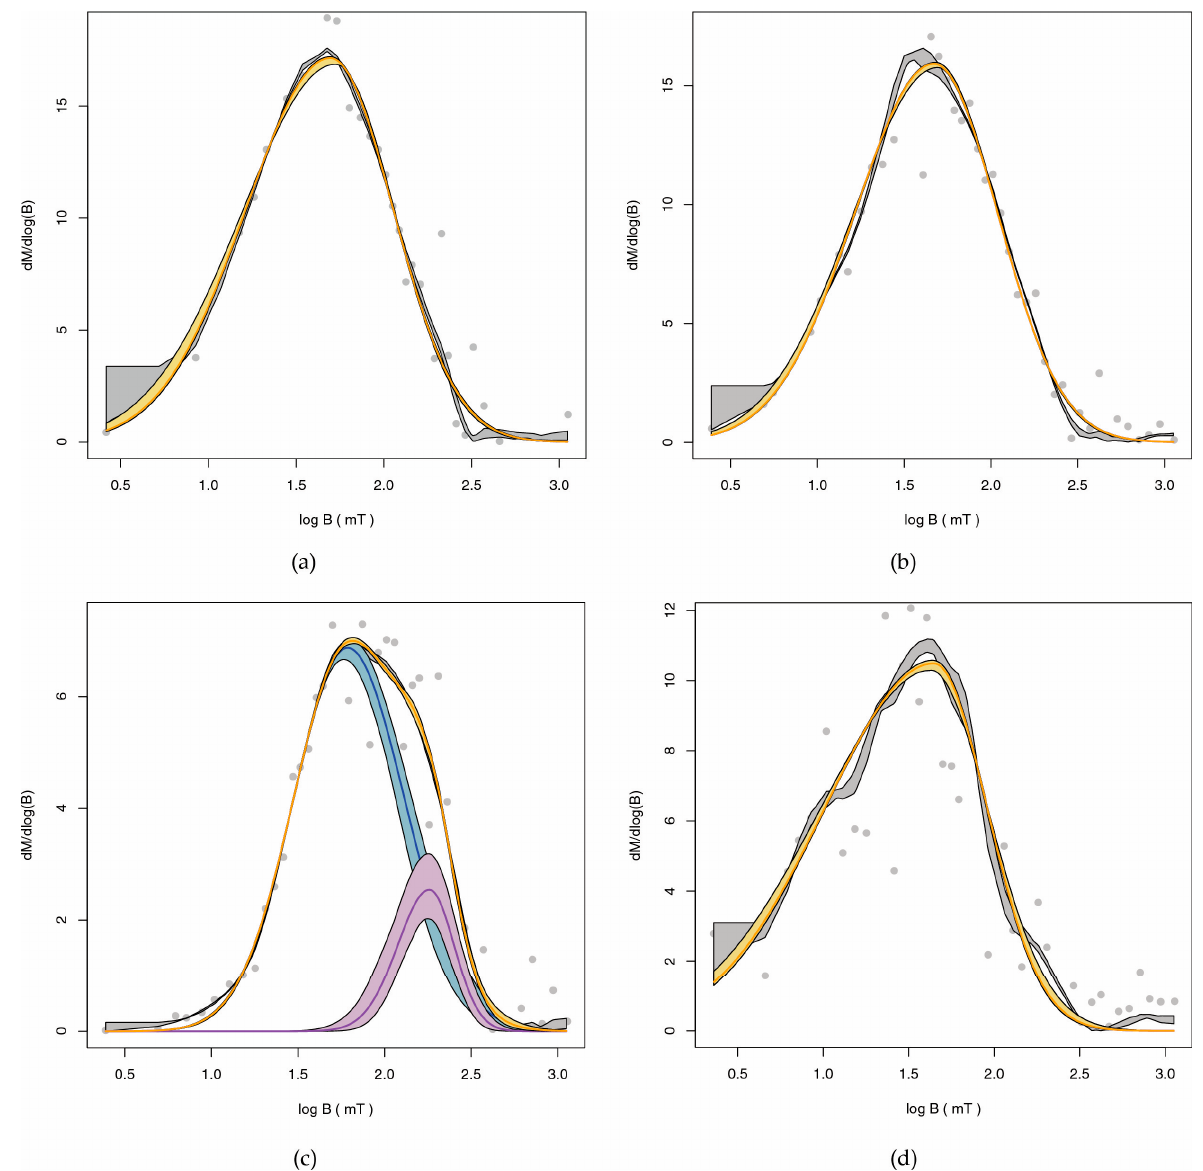
Figure 8. Adjustments of the IRM curve using the MAX UnMix software for the samples: ( a ) ES18-A1; ( b ) ES18-B2; ( c ) ES19-A1; ( d ) ES87-C2. The solid yellow line represents the coercivity distribution of the sample. The thickness of the line is the standard deviation of the estimated error. The other blue and purple lines represent the coercivity distributions of each identified component, and their thickness indicates the range of coercivity